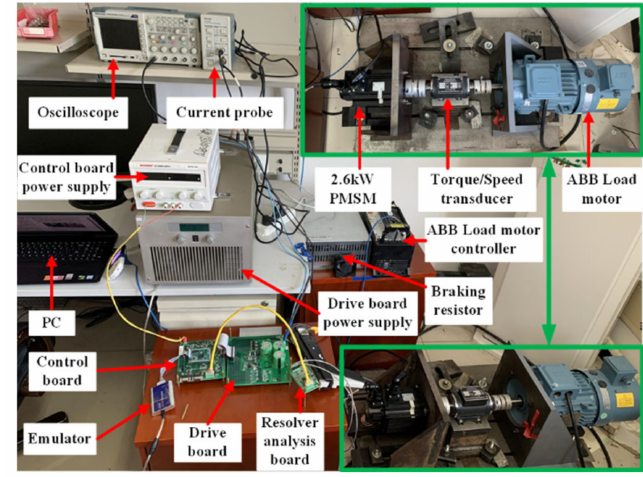
Figure 7. Experimental platform of the PMSM system.